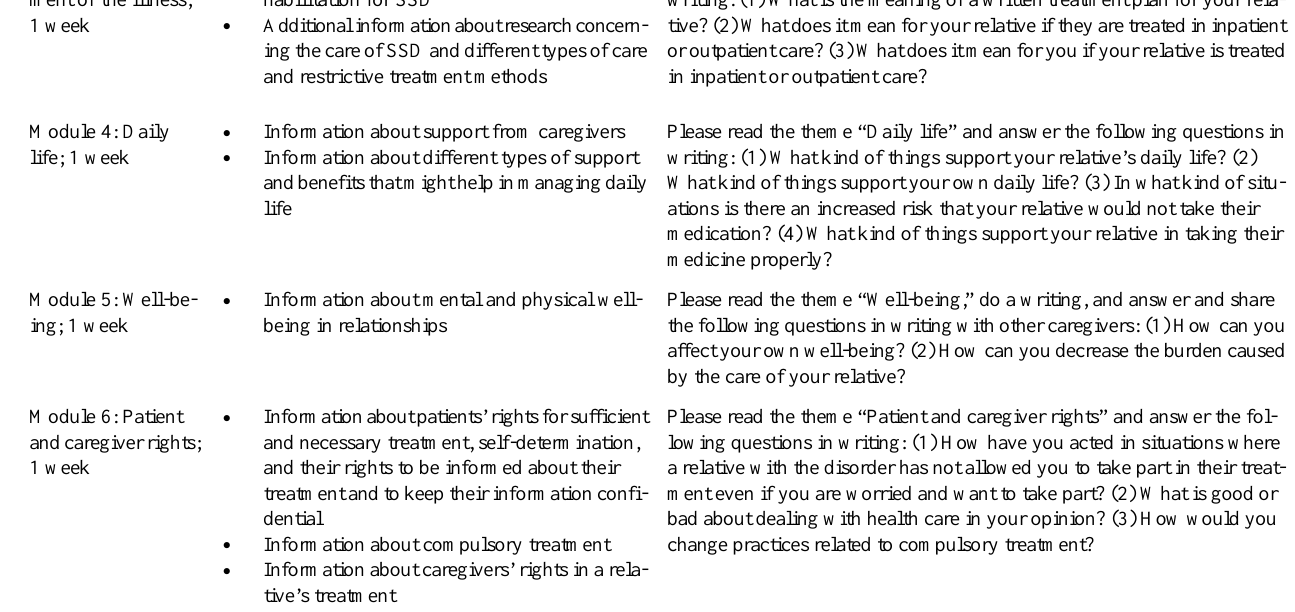
Task of the weekContentModule and